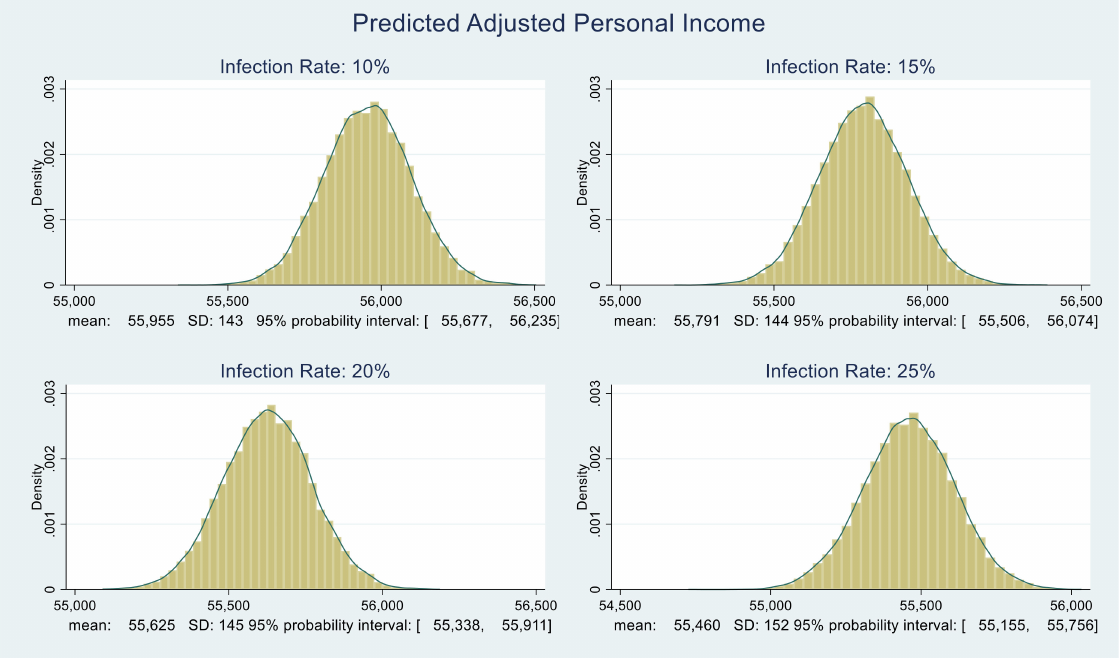
Figure 4. Predictive distributions of Florida adjusted personal income in